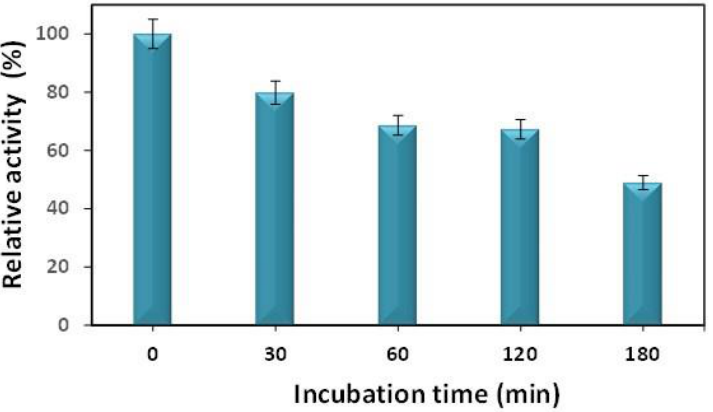
Figure 8. Thermal stability of the immobilized biocatalyst incubated at